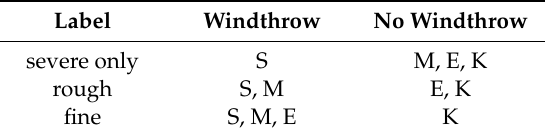
Table 4. Evaluation groups for detection of windthrow hotspots. For details of the abbreviationsrefer to Table 2.